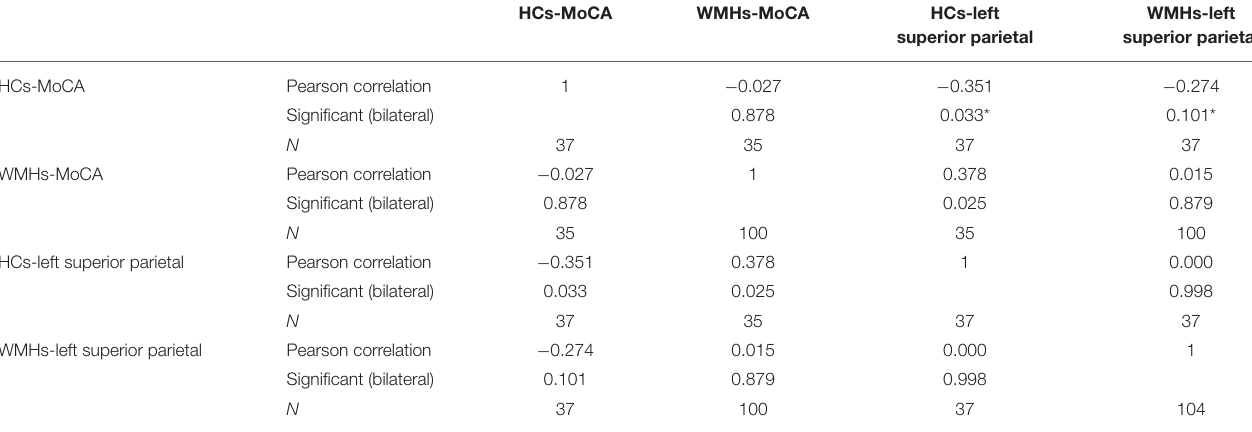
HCs-MoCA WMHs-MoCA HCs-left